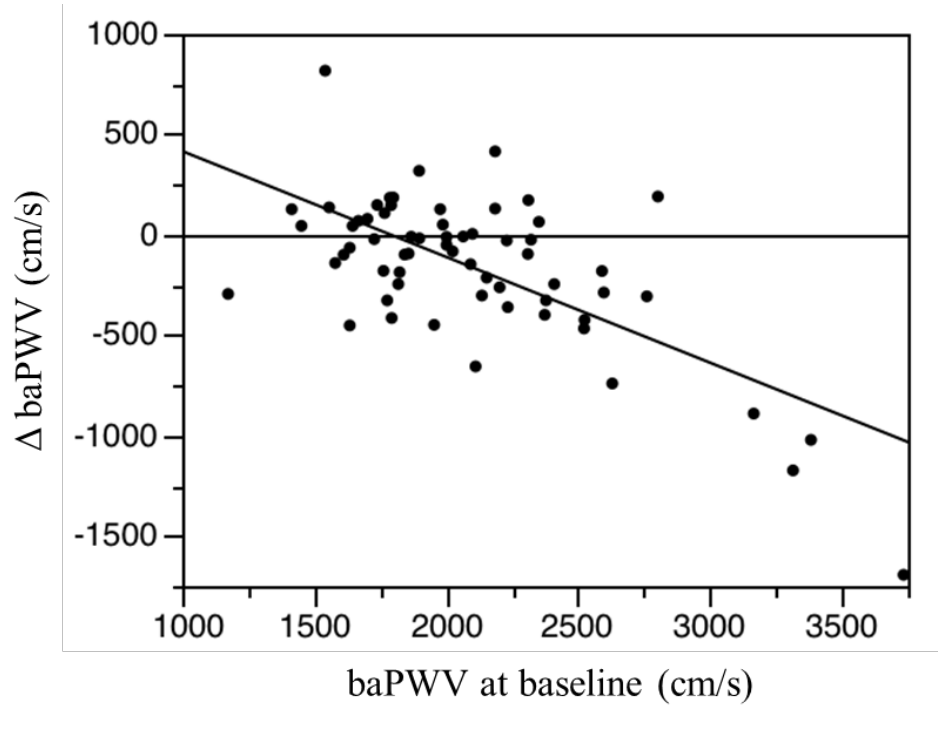
Figure 3. Linear regression analysis of the association between ΔbaPWV (differences between the 12-month baPWV and baseline baPWV) and baseline baPWV (brachial-ankle pulse wave velocity) in the L -carnitine treatment group. Y = −0.527 X + 943.604, r = −0.677, p < 0.0001, n = 67.